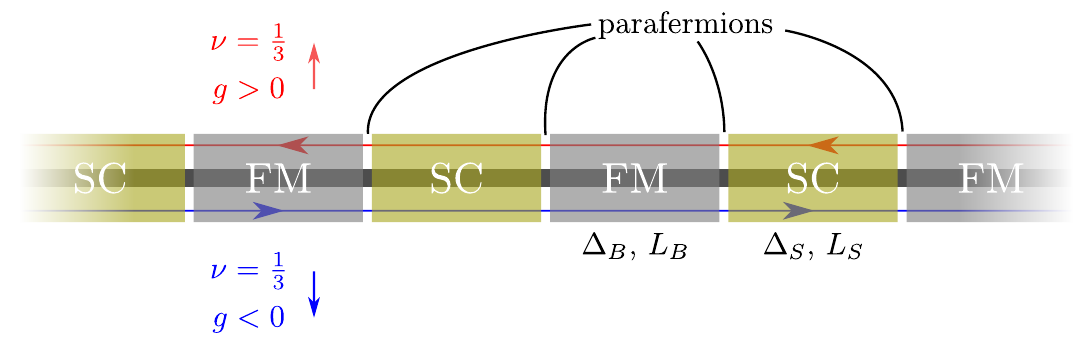
Figure 1: Schematic display of a fractional quantum Hall system with appearing effec- tive parafermion degrees of freedom. The alternating placement of superconductors (SC) and ferromagnets (FM) traps the edge modes. These trapped modes obey the (cid:90) -parafermion 6